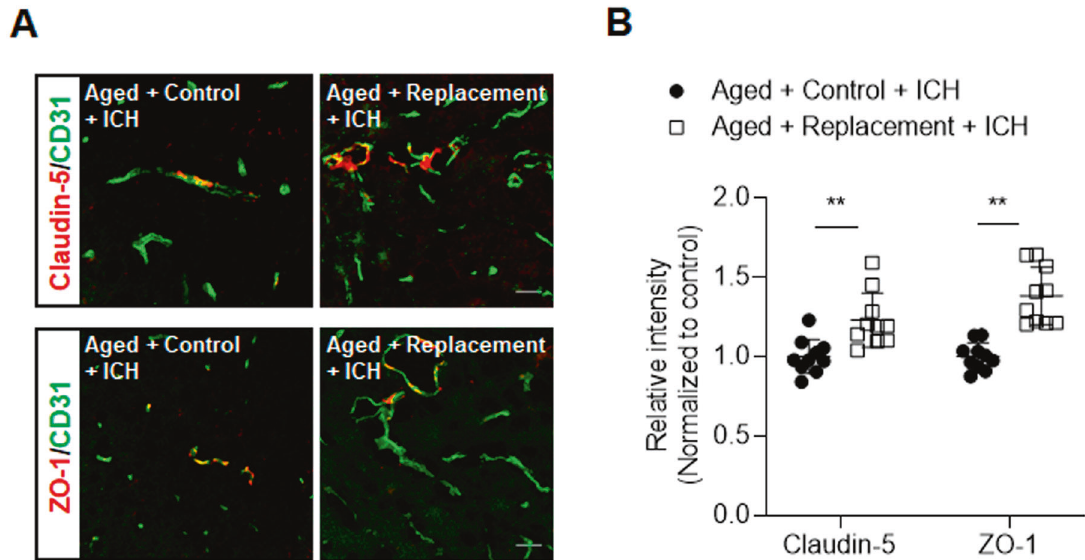
Fig. 3 Effects of microglial replacement on blood-brain barrier integrity after ICH in the aged mice. ICH was induced in mice by injection of collagenase. A Brain sections from ICH mice in microglial repopulation group or control group were stained with CD31 (green), Claudin-5 (red), and ZO-1 (red) at day 3 after ICH. Scale bar: 20 µm. B Summarized results show that microglial repopulation had reduced Claudin-5 and ZO-1 loss in immuno fl uorescence intensity within the lesion area after ICH in aged mice. n = 10 sections from two mice per group. Data are presented as mean ± SD. ** p < 0.01.